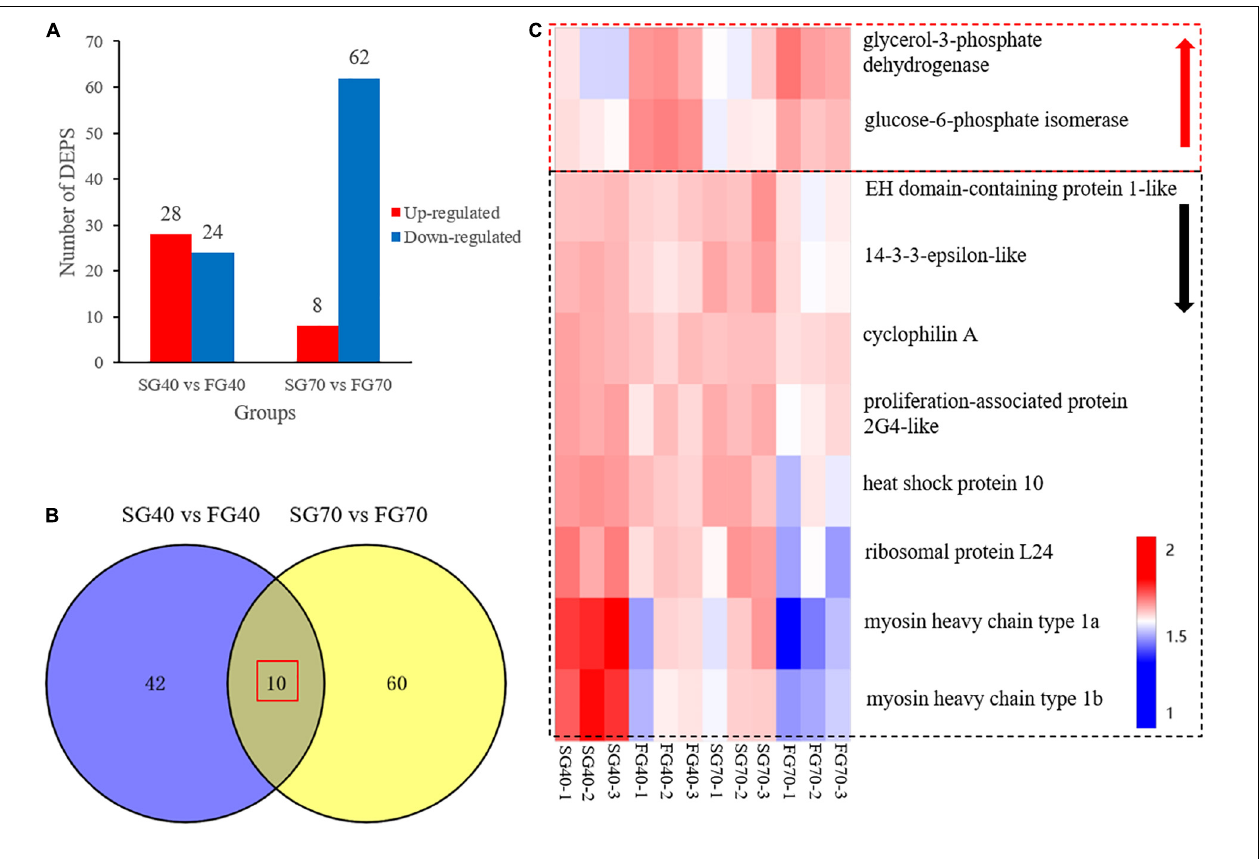
FIGURE 3 | Comparative analysis of DEPs of M. japonicus in the fast growth group and slow growth group at the fast growth stage and steady growth stage. (A) Number of DEPs in the fast growth stage and steady growth stage; (B) Venn diagram of DEPs in the fast growth stage and steady growth stage; (C) heat map of the 10 shared DEPs identified during the fast growth stage and steady growth